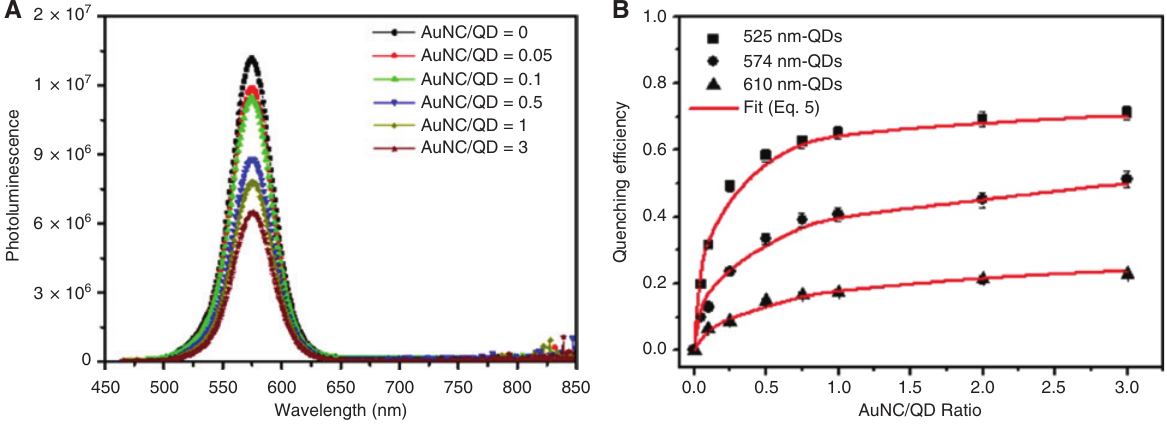
Figure 16: Effect of AuNP:QD ratio on quenching efficiency observed. (A) Quenching efficiency of CdSe/ZnS QDs by AuNPs at various concentration ratios. As the amount of AuNPs increases, observed fluorescence decreases (quenching efficiency increases). (B) Observed quenching efficiency versus AuNP/QD ratio using QDs with different fluorescence wavelengths. The quenching efficiency is higher when the fluorescence wavelength is closer to the wavelength of the plasmon resonance in the AuNPs. Adapted with permission from Ref. [41]. Copyright 2013 American Chemical Society.